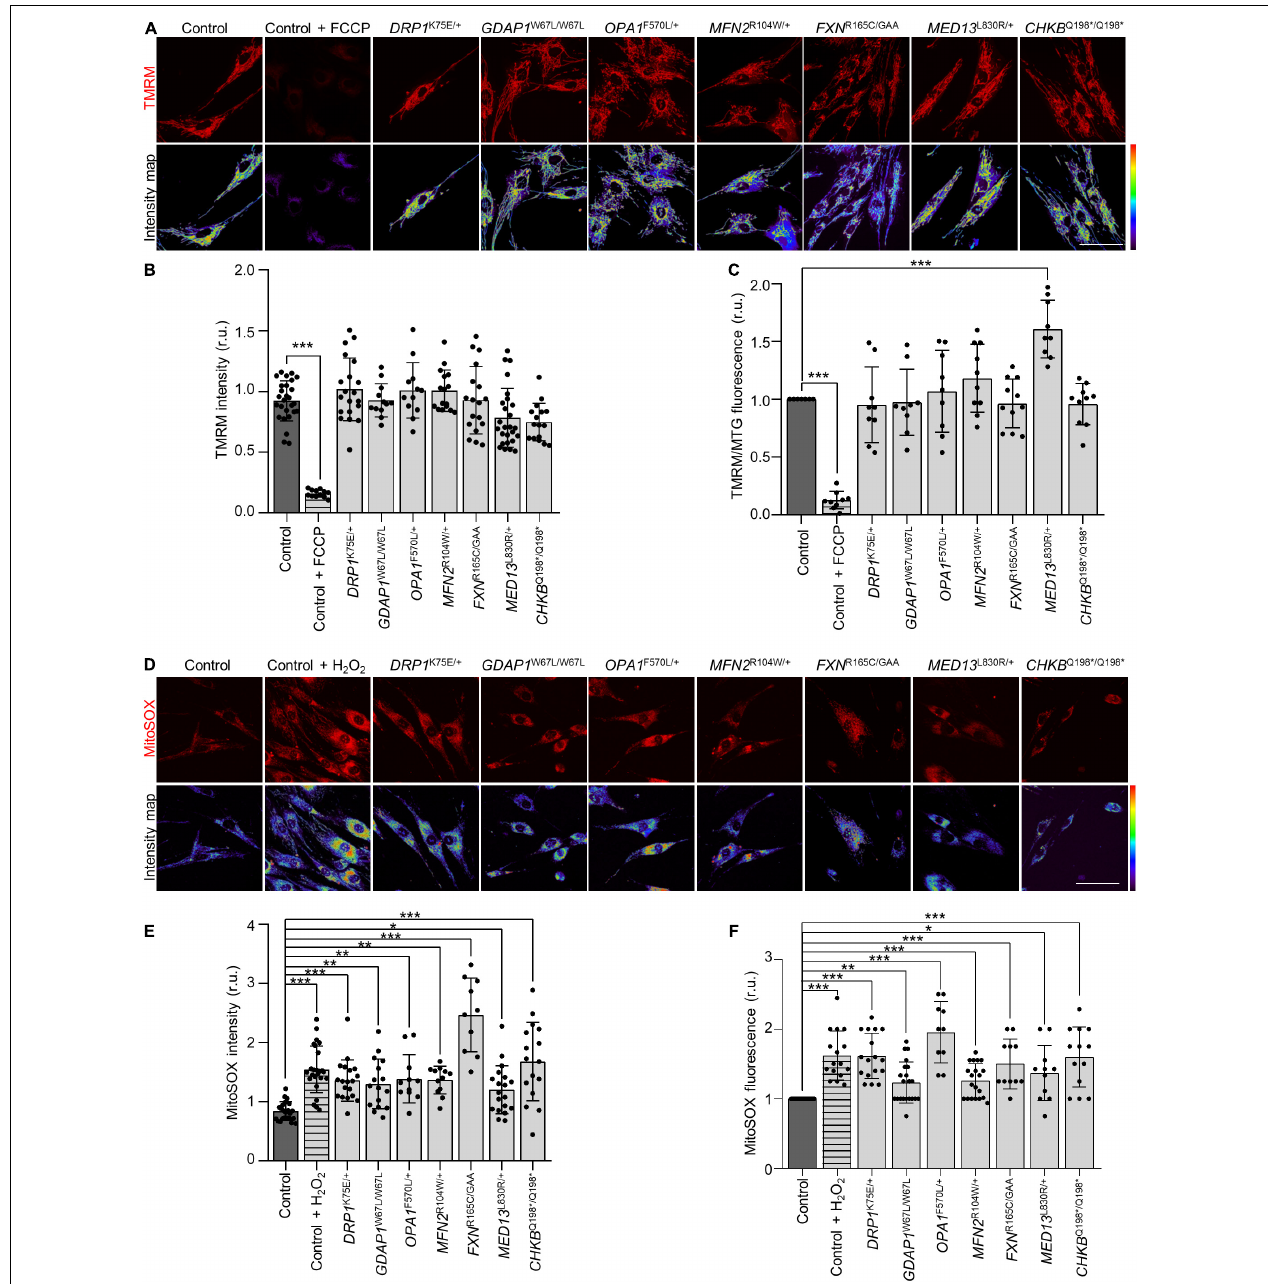
FIGURE 3 | Increased mitochondrial reactive oxygen species (ROS) in patients’ fibroblasts without alterations in mitochondrial membrane potential ( (cid:49)(cid:57) ). (A) Representative images of in vivo TMRM staining in control and patients’ fibroblasts and the corresponding scattering intensity color map. As positive control cells were treated with 50 µ M carbonyl cyanide- p -trifluoromethoxyphenylhydrazone (FCCP). Scale bar: 75 µ m. (B) Quantification of in vivo TMRM intensity in control and patients’ fibroblasts. Data represent mean ± SD and individual values are displayed as dots. One-way ANOVA followed by Dunnett’s multiple comparisons test. Three independent experiments. *** P < 0.001. (C) Mean TMRM fluorescence intensities relative to MitoTracker Green (MTG) by flow cytometry. As a positive control, cells were treated with 50 µ M FCCP. Data represent mean ± SD and individual values are displayed as dots. One sample t -test with multiple comparison adjustment. Three independent experiments. *** P < 0.001. (D) Representative images of in vivo MitoSOX staining in control and patients’ fibroblasts and the corresponding scattering intensity color map. As positive control cells were treated with 2 mM hydrogen peroxide (H 2 O 2 ). Scale bar: 75 µ m. (E) Quantification of in vivo MitoSOX intensity in control and patient fibroblasts. Data represent mean ± SD and individual values are displayed as dots. One-way ANOVA followed by Dunnett’s multiple comparisons test. Three independent experiments. * P < 0.05, ** P < 0.01, *** P < 0.001. (F) Mean MitoSOX fluorescence intensities relative to control fibroblasts by flow cytometry. As a positive control, cells were treated with 500 µ M H 2 O 2 . Data represent mean ± SD and individual values are displayed as dots. One sample t -test with multiple comparison adjustment. Three independent experiments. * P < 0.05, ** P < 0.01, *** P < 0.001. r.u., relative units.